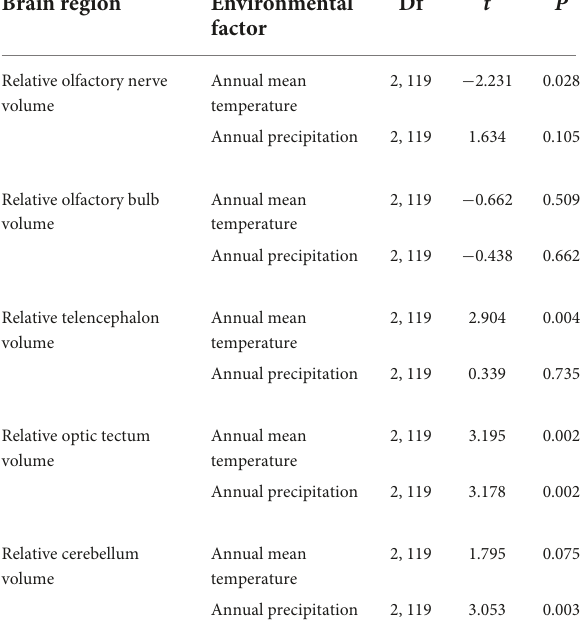
TABLE 3 The effects of annual mean temperature and annual precipitation on variation in the relative volume of brain region of the Feirana quadranus using multiple linear regression model